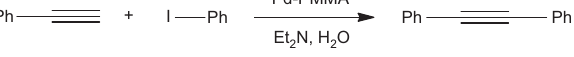
Scheme 1 Sonogashira reaction of iodobenzene and phenylacety- lene in